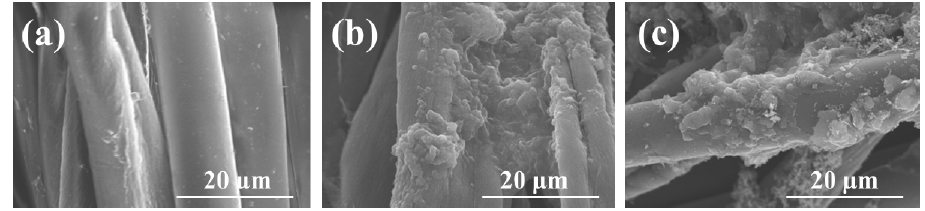
Figure 2. SEM images of ( a ) pristine cotton fibers and polyester fibers. ( b ) Diber-loaded c-MWCNTs and ( c ) fiber-loaded c-MWCNTs and PPy.